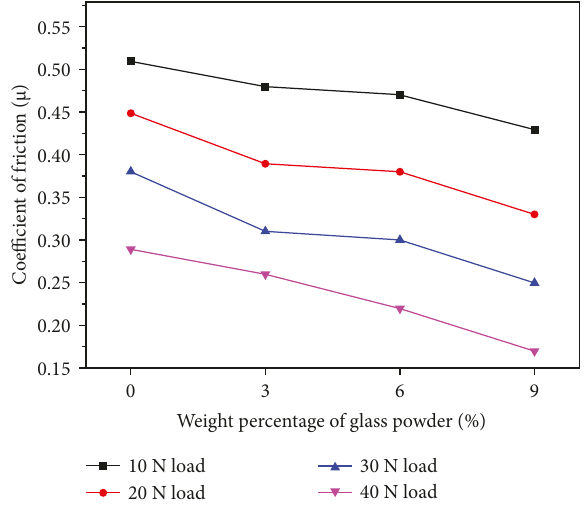
Figure 9: Variation of wear rate with the reinforcement contained at the different applied load conditions.